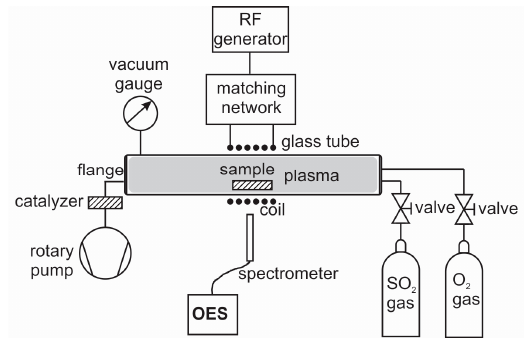
Figure 1. Schematic diagram of the experimental system.